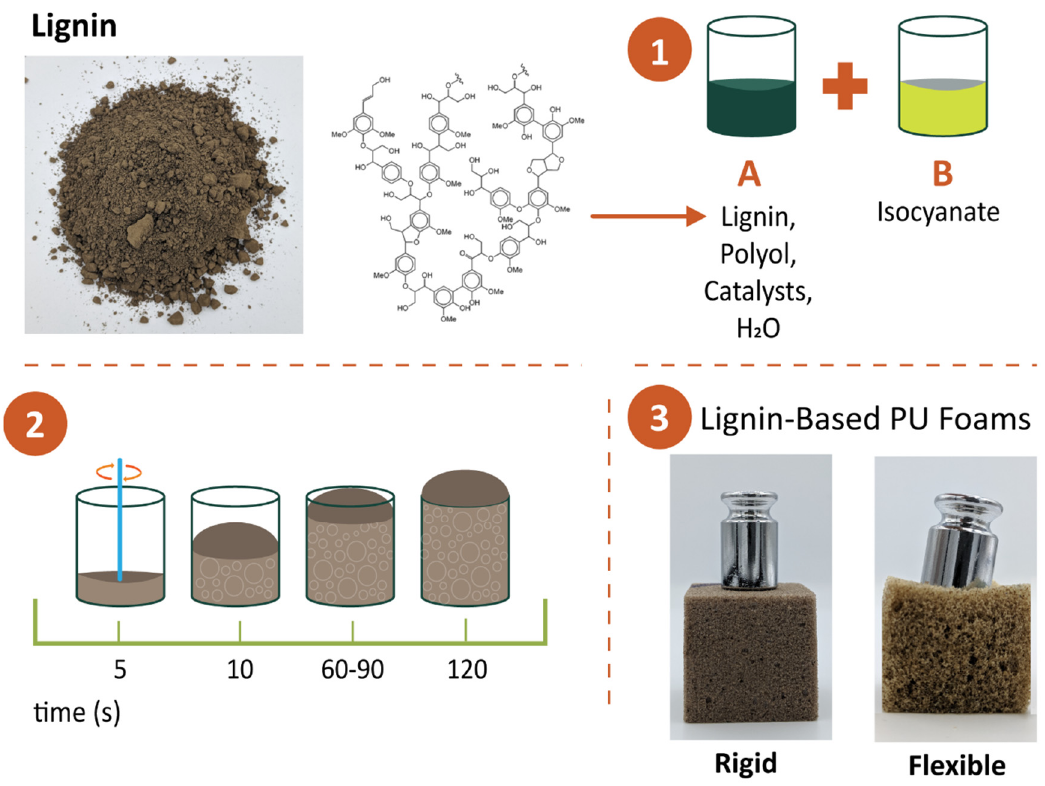
Figure 5. Schematic showing production of rigid and flexible lignin-based polyurethane foam.